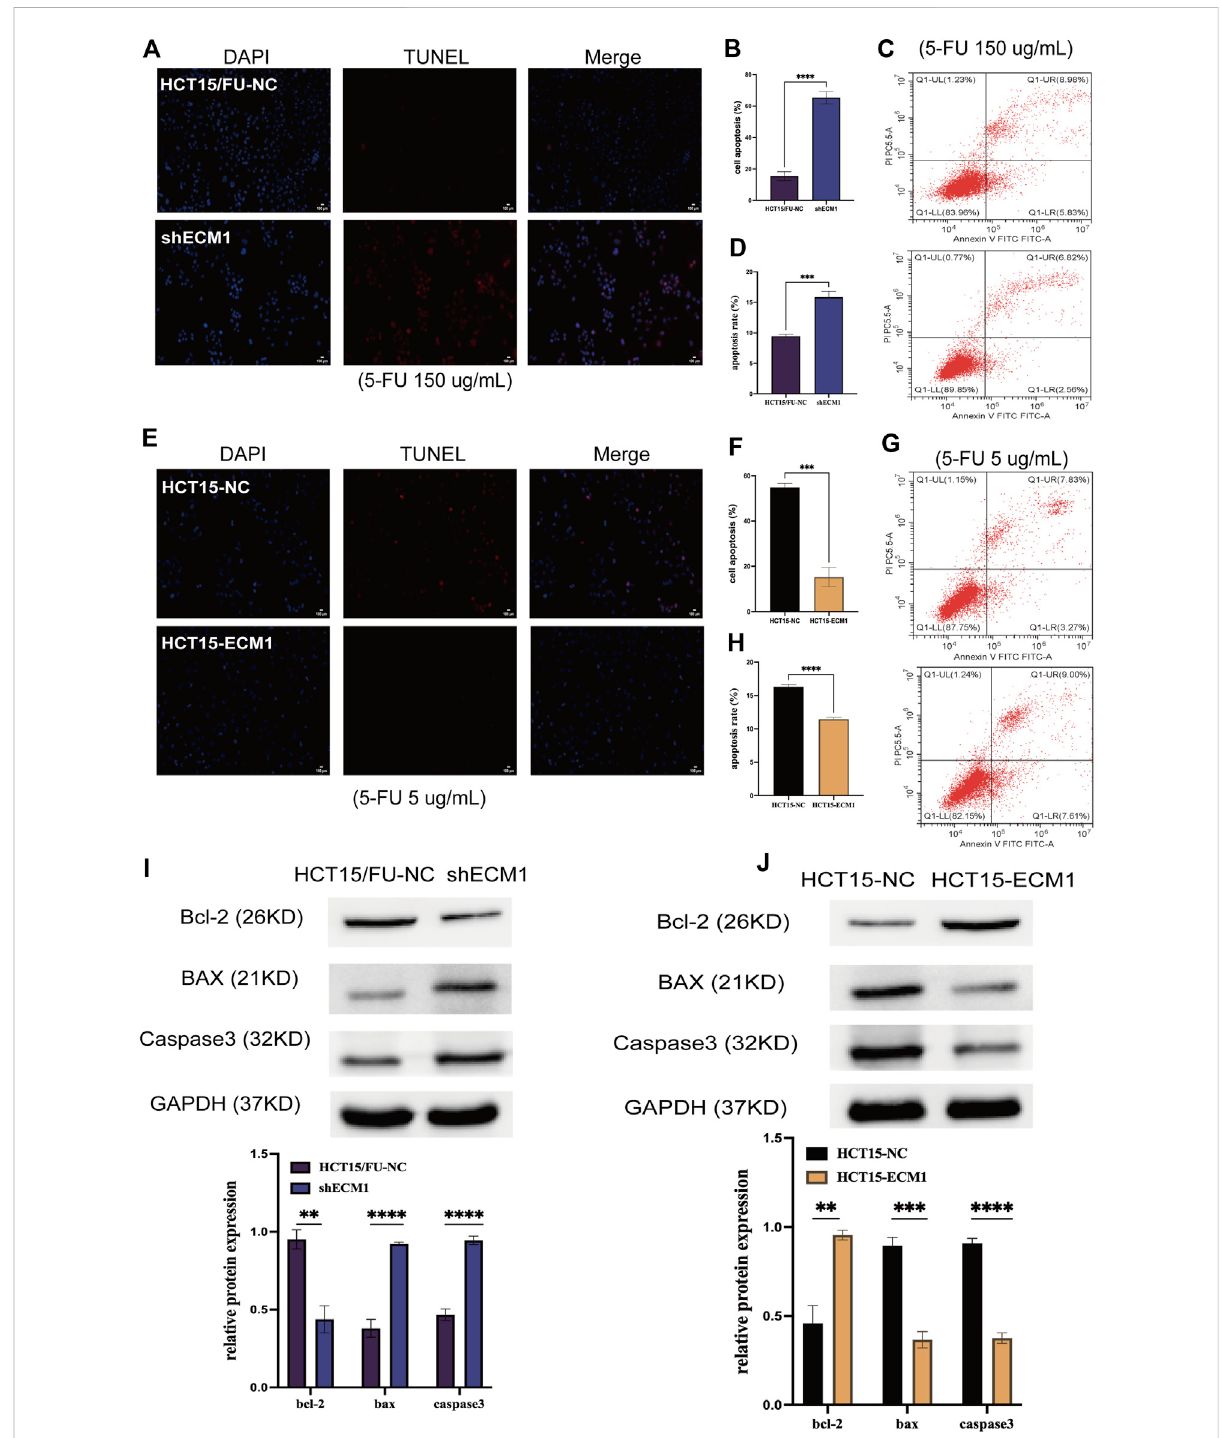
FIGURE 5 ECM1 regulates cellular resistance to 5-FU-induced apoptosis. The apoptotic death of 5-FU-treated cells was examined through TUNEL staining and fl ow cytometry. (A – H) The impact of altered ECM1 expression on the apoptosis of 5-FU-treated cells. (I,J) Apoptosis-related protein expression was detected via Western immunoblotting. Data are means ± SD (* p < 0.5, ** p < 0.01, *** p < 0.001, **** p <